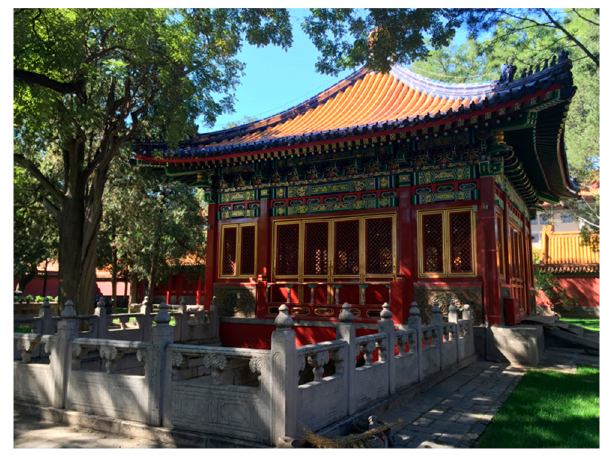
Figure 1. Exterior of Lin’xi Pavilion.